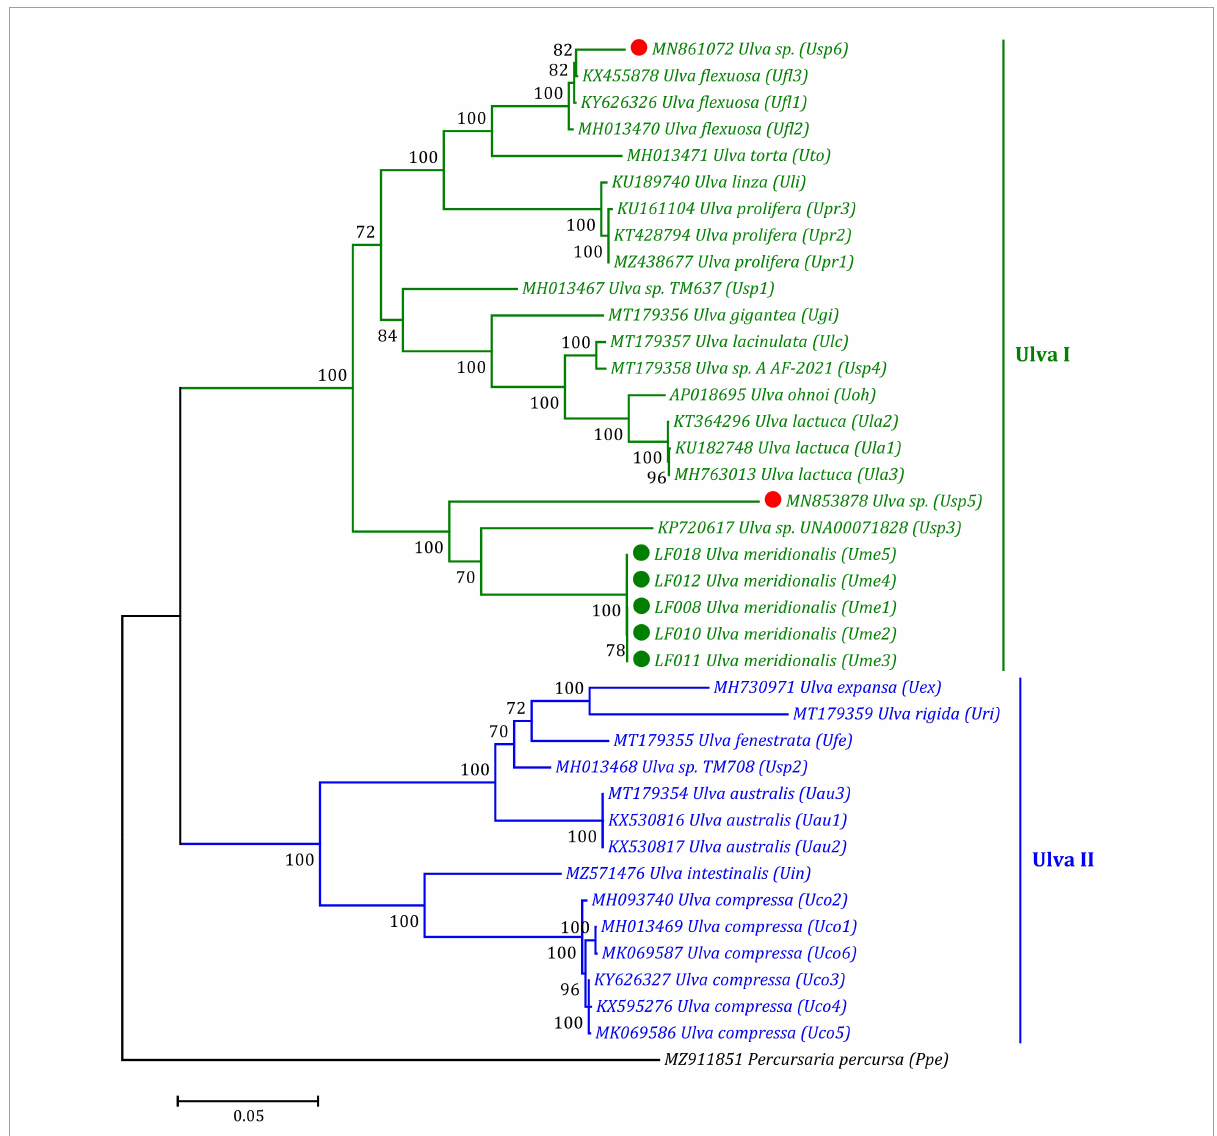
FIGURE7 Phylogenomic tree based on Maximum Likelihood (ML) analysis of the amino acid (aa) sequences of 32 genes in 39 ulvalean mitogenomes. The ML analysis was performed with 1,000 bootstrap replicates using MEGA 7.0. The bootstrap support values greater than 70% were displayed at branches. Branch lengths were proportional to the amount of sequence change, which were indicated by the scale bar below the trees. Ulva prolifera (MN853878) and Ulva meridionalis (MN861072) deposited in the GenBank database were corrected to Ulva sp. (MN853878) and Ulva sp. (MN861072), respectively, due to their wrong species name assignment. The tree was rooted with Percursaria percursa (MZ911851) as an